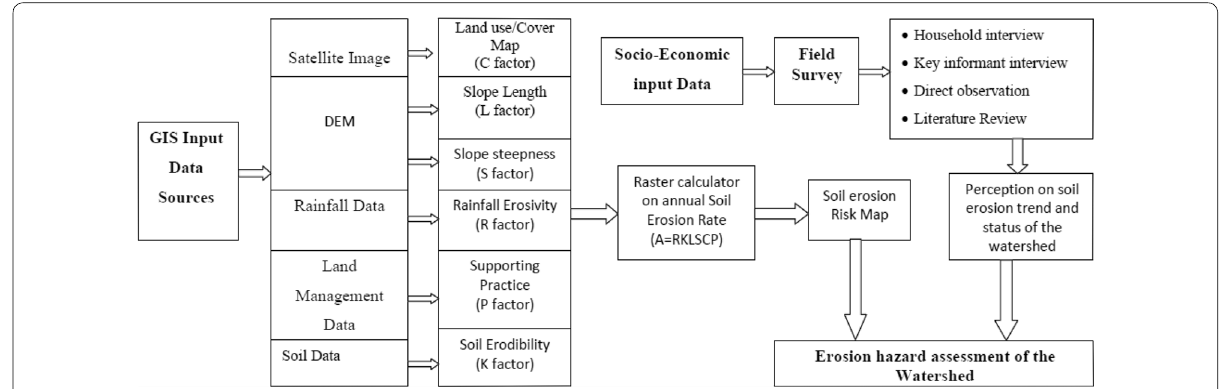
Fig. 6 The overall sequential step used employed to estimate soil loss by RUSLE